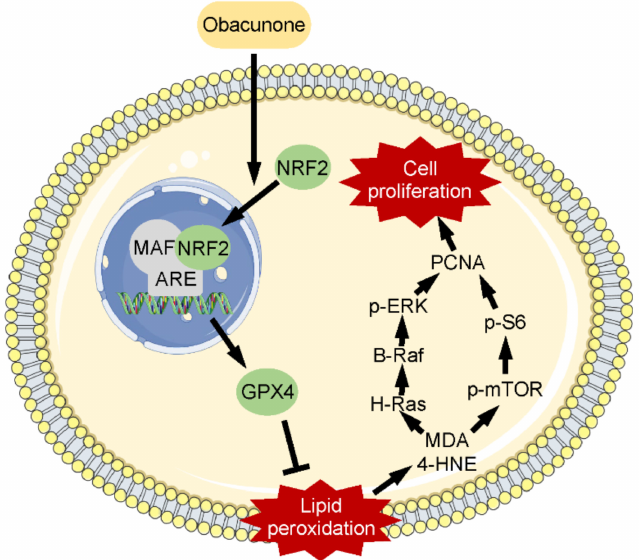
Figure 8. The suggested pharmacological mechanism of obacunone in ADPKD. See text for